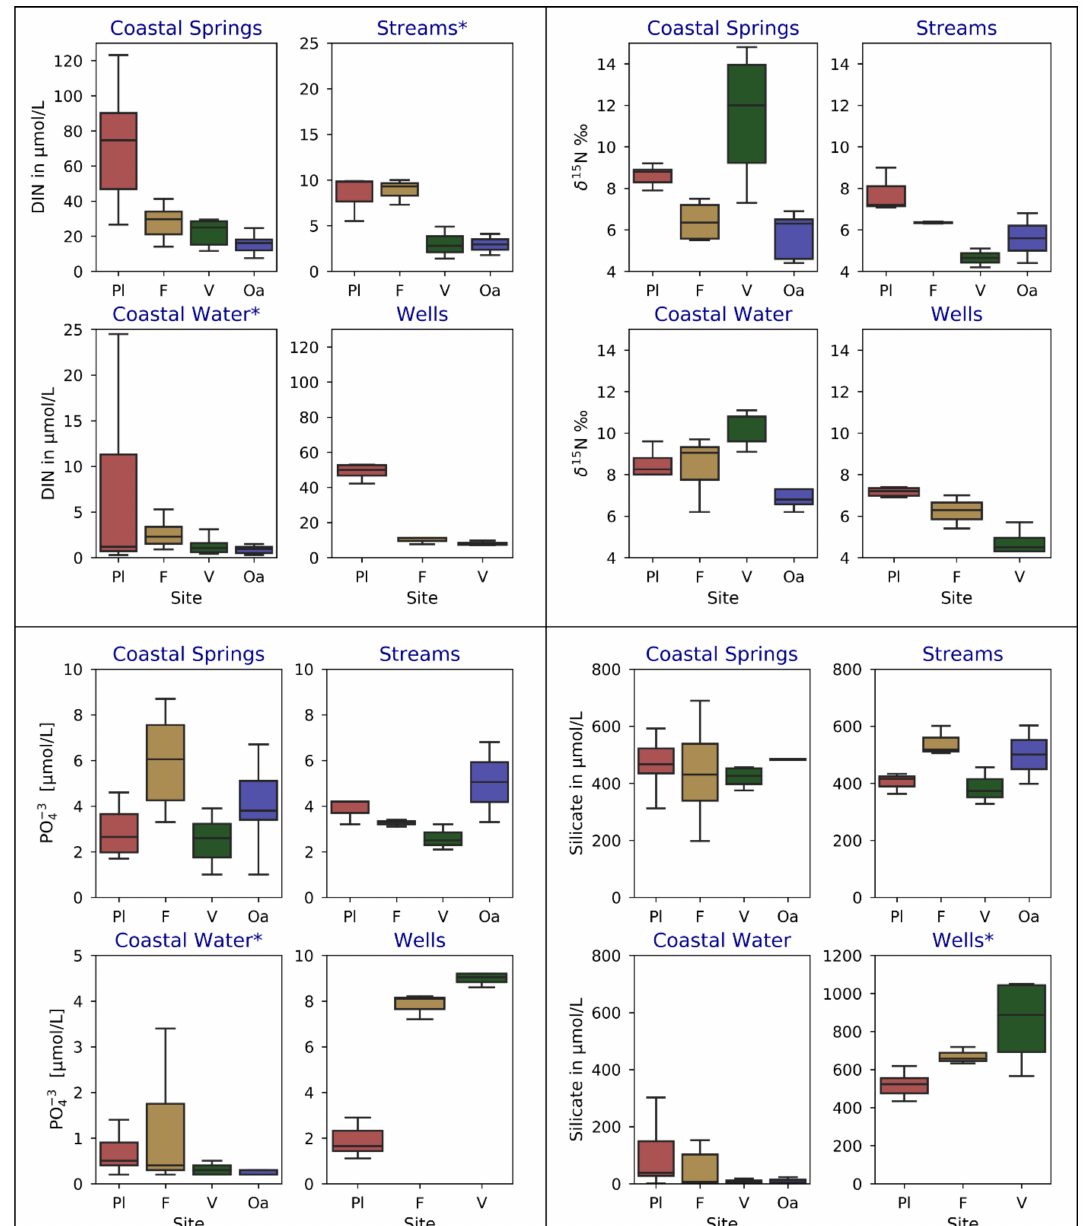
Figure 5. Box plots of water quality sample results. Box center lines represent median, edges represent interquartile range, and whiskers represent range. Site names are coded as, Pala Lagoon: Pl, Faga’alu: F, Vatia: V, and Oa: Oa. Note that the stream in Oa bay was sampled in the perennial section above where it infiltrated into the ground. Note that subplot titles marked with asterisks (*) have modified